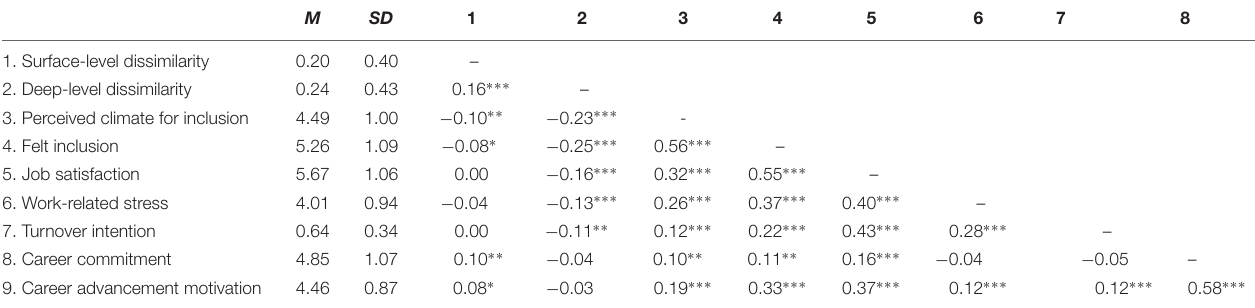
TABLE 1 | Descriptive Statistics and